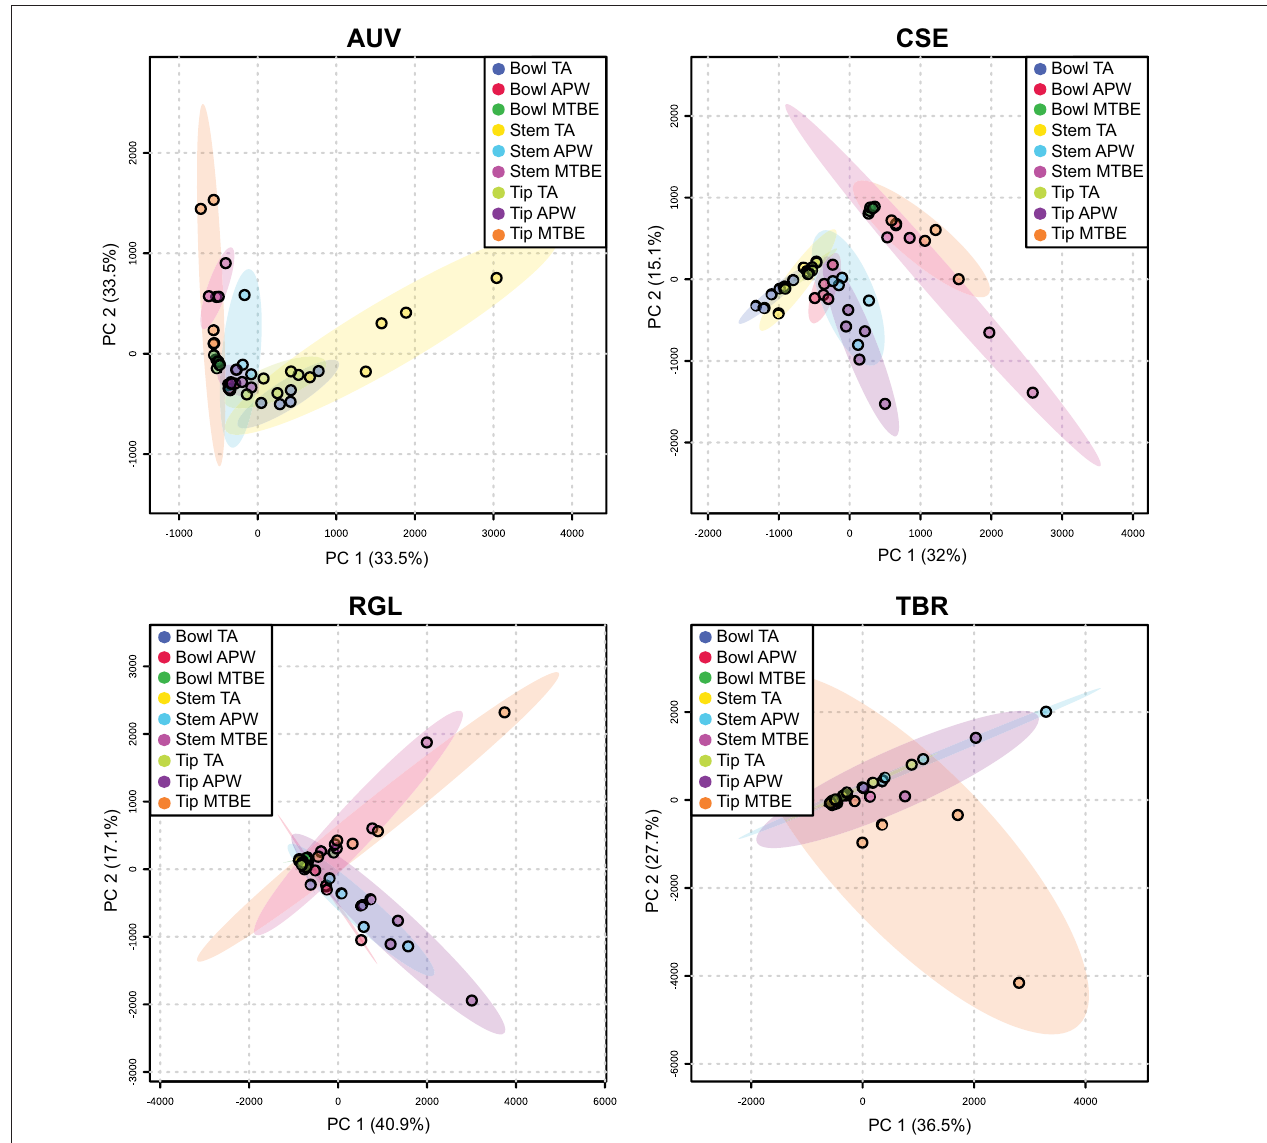
FIGURE 4 | Principal component analysis (PCA) of experimental pipes by section (i.e., bowl, stem, and tip) smoked with A. uva-ursi ( AUV ), C. sericea ( CSE ), R. glabra ( RGL ), and T. brevifolia ( TBR ). TA, APW, and MTBE correspond to 2% aqueous tartaric acid, acetonitrile:2-propanol:water [3:2:2], and methyl tert -butyl ether, respectively. Each point within the 95% confidence regions represents five different pipe replicates ( n =